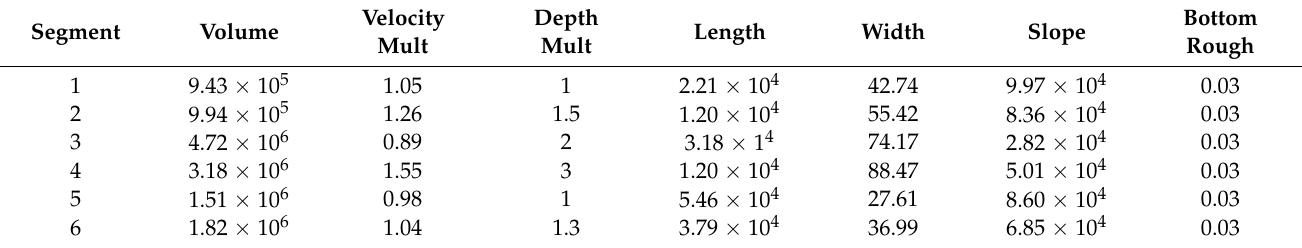
Table 1. Segment information of Lushui